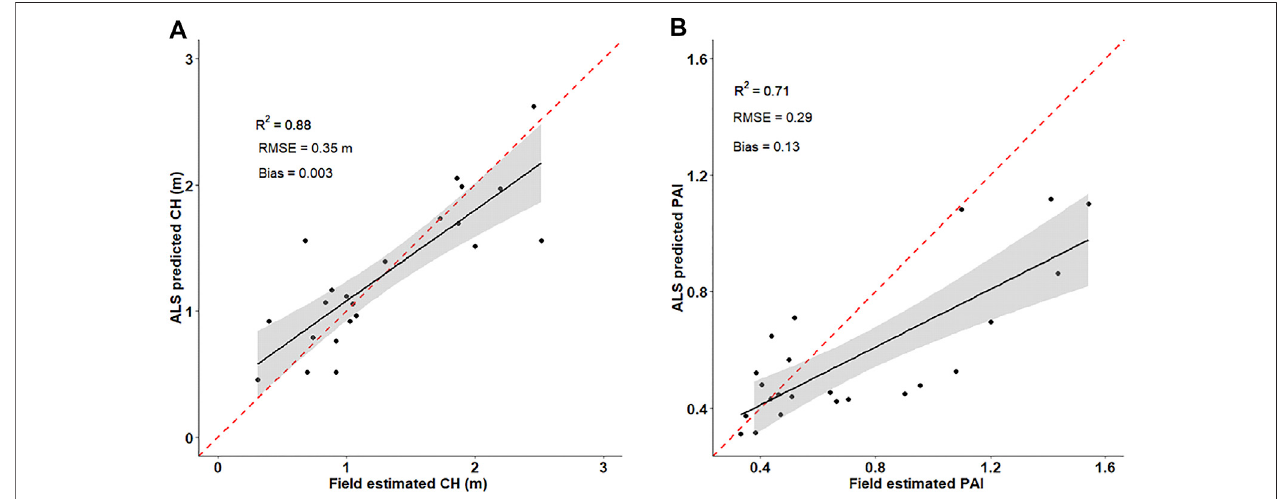
FIGURE2| Correlationbetween (A) fi eldandALSestimatedcanopyheightcanopyheights, (B) fi eldandALSestimatedplantareaindex(PAI).Thesolidgreenlines represent the best fi t line while the gray areas are the 95% con fi dence interval. The dashed red line represents the 1:1 line.